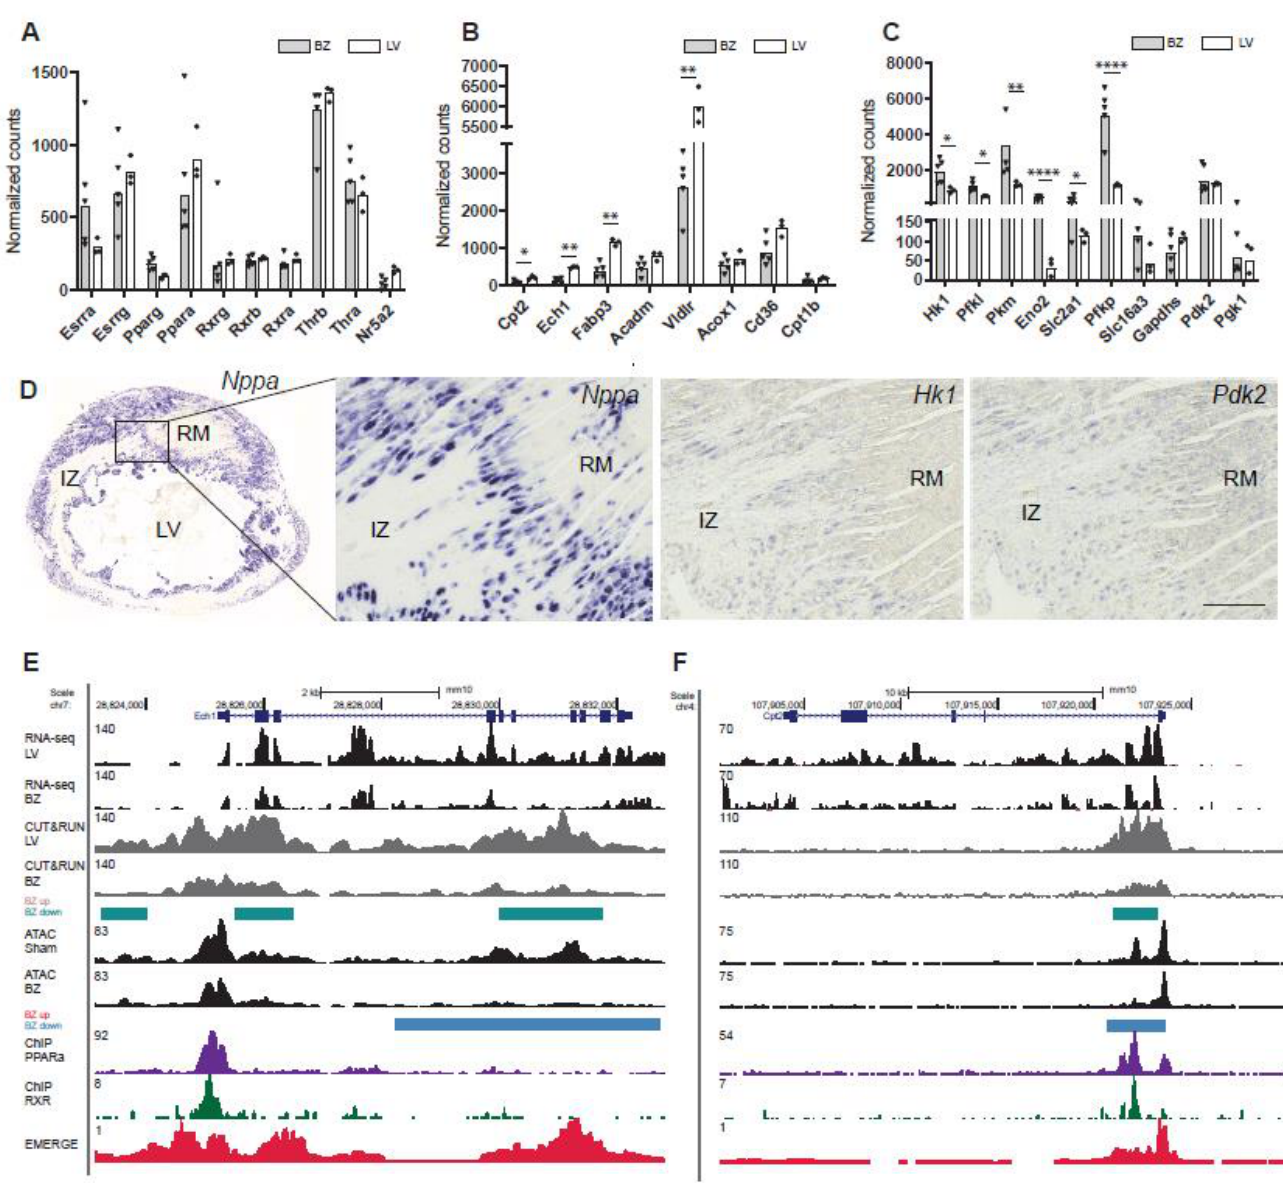
Figure 4. Average expression of NR transcription factors ( A ), PPAR target genes ( B ), and glycolytic genes ( C ) shown as normalized counts in border zone (BZ) samples ( n = 5) and samples from the healthy left ventricle ( n = 3). ( D ) Expression of Hk1 and Pdk1 is induced in Nppa+ BZ cardiomyocytes, Pdk1 expression is also visible in the RM as shown by in situ hybridization; scale bar 0.1 mm. UCSC genome browser views of ( E ) Ech1 and ( F ) Cpt2 . ATAC-seq, assay for transposase- accessible chromatin using sequencing; CUT&RUN-seq, cleavage under target and release using nuclease-sequencing; ChIP, chromatin immunoprecipitation sequencing; BZ, border zone; RM, remote myocardium; IZ, infarct zone; and LV, left ventricle. * p < 0.05, ** p < 0.01, **** p < 0.0001.